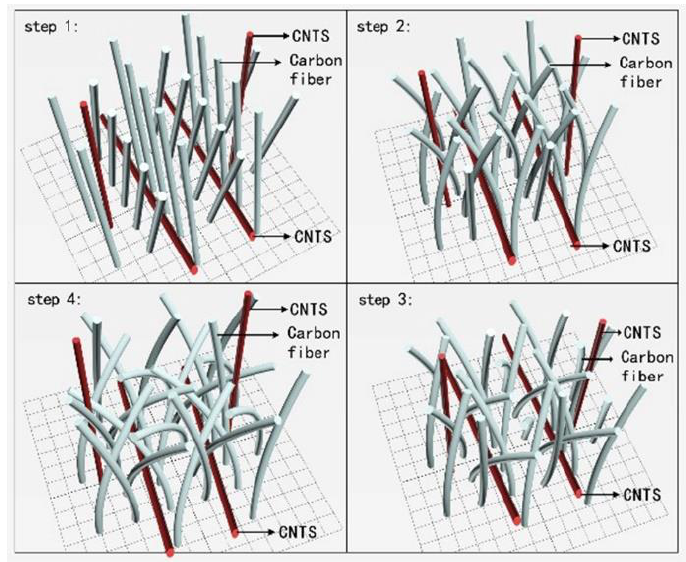
Figure 2. Computer simulation of 3D six-directional braiding technology.